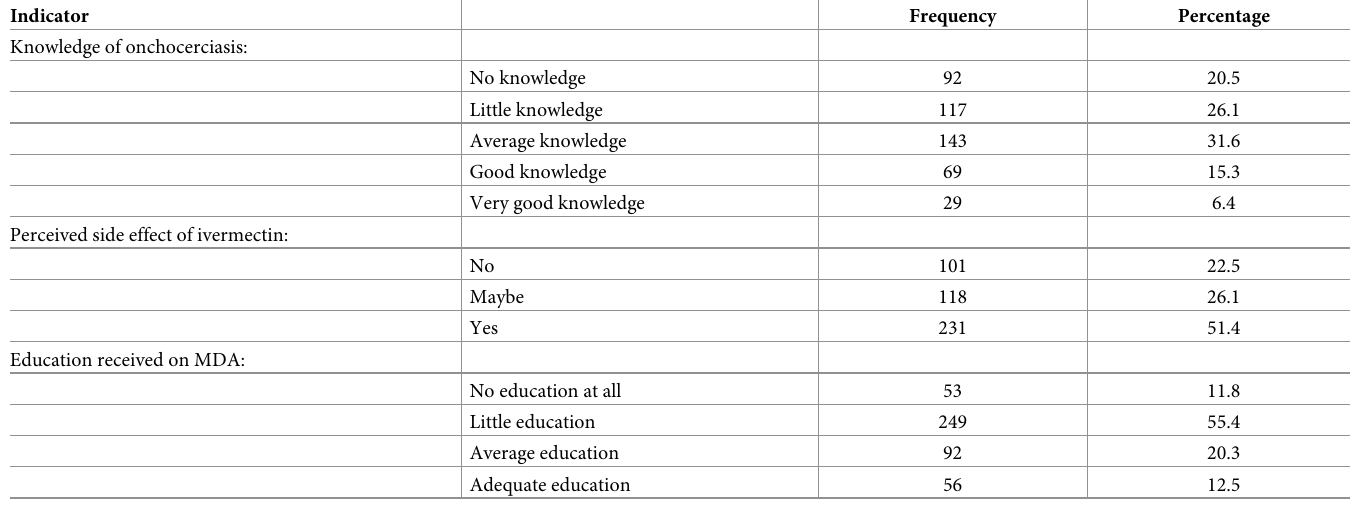
Table 3. Knowledge, perceived side effect, and level of education received on ivermectin mass drug administration.